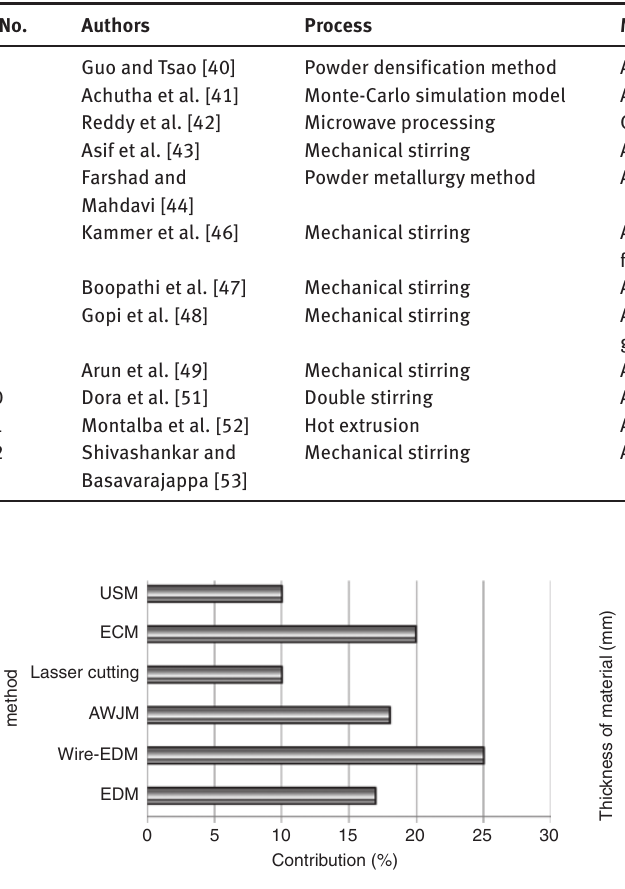
Figure 7: Contribution of research of nonconventional machining.